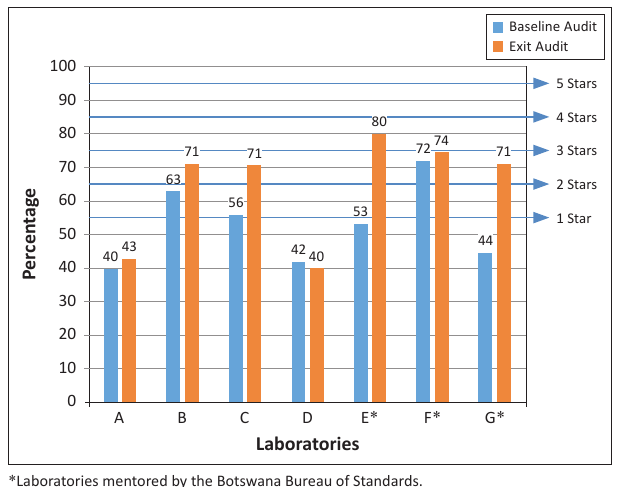
FIGURE 3: Mean QSE scores of (a) BOBS-mentored laboratories ( n = 3) and (b) non-BOBS-mentored laboratories ( n = 4) at the baseline and exit audits, Botswana SLMTA programme